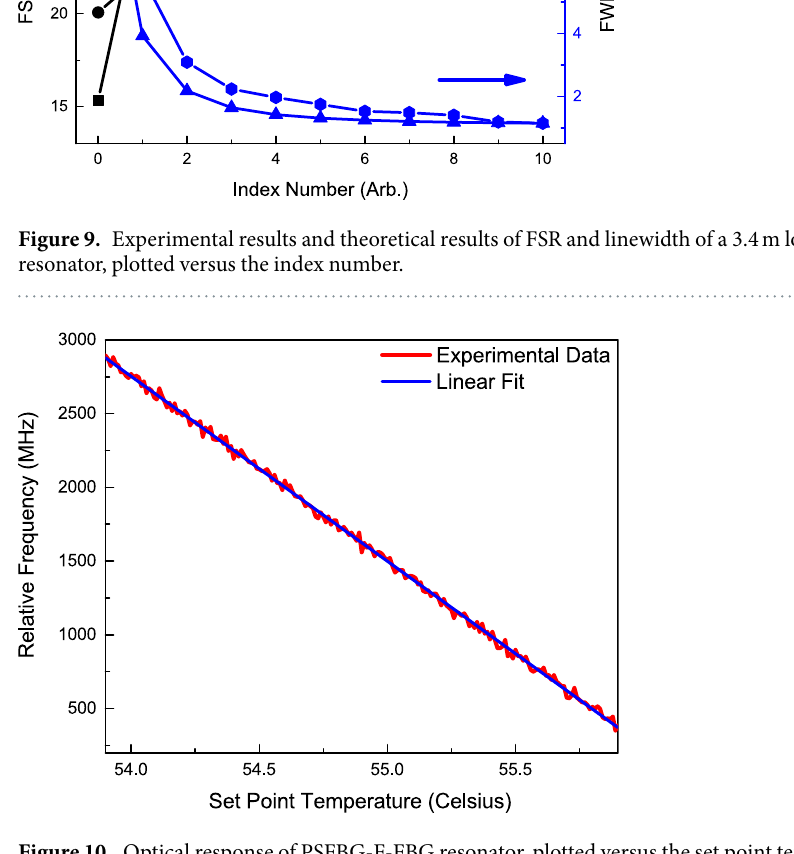
frequency is about 30 MHz and linewidth is about 1 MHz, which yields a finesse of 30. At the impedance matched frequency, the FSR is about 22 MHz and linewidth is about 6 MHz, which yields a finesse of 4. This implies that the highest finesse of this resonator with a given cavity length is not obtained at the impedance matched cavity mode. The optimal choice of cavity mode depends on the type of applications, and for conventional purpose the imped- ance matched cavity mode is an optimal balanced mode between the amplitude of cavity mode and the coherent linewidth. For the impedance matched cavity mode, the linewidth of 3.4 m long cavity is twice as the linewidth of 7.3 m long cavity. This implies that the linewidth of impedance matched resonant peak can be further improved by continuously increasing the cavity length, until the broadening effect on linewidth owing to the decreasing of cavity finesse, which depends on the transmission rate of PSFBG, suppresses the narrowing effect on linewidth attributed to the increasing of cavity length. Figure 10 shows the optical response of PSFBG-F-FBG sensor as a function of controlling temperature. In order to obtain its optical response to temperature, the PSFBG-F-FBG resonator was coiled into a 20 mm radius ring and putted into a 50 × 50 × 15 mm temperature controlled aluminum rectangle box. The probe laser is a diode laser with a polarization linearity > 100:1 (DL PRO, Toptica), which was locked to a resonant peak of ultra-stable Fabry-Perot cavity by PDH technique. The output light of the stabilized laser was modulated by an EO phase modulator (EOSPACE) to generate second carriers. The drive signal of the phase modulator was generated by a voltage-control oscillator, to scan the frequency of second carriers to obtain the relative frequency between 3 MHz narrow linewidth resonant peak of PSFBG-F-FBG resonator and the laser carrier. For each data point, the control temperature of LFI-3751 was set and waited for 30 seconds until the system reached thermal equilib- rium where the temperature fluctuation was less than 0.01 °C. According to the linear fit of experiment results in Fig. 10, the slope of frequency-temperature response of PSFBG-F-FBG sensor is about − 1250 MHz/°C. To the 3 MHz narrow linewidth resonant peak, its temperature resolution can reach to 0.002 °C.